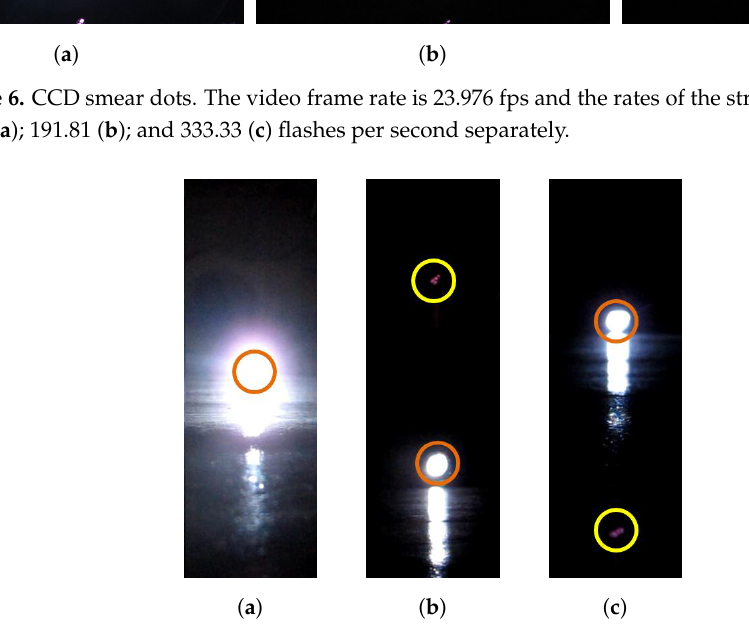
Figure 7. Smear effects when the video frame rate equals the flash rate of the strobe light. The orange circle indicates the light source position and the yellow circle indicates the smear dot position. ( a ) shows that the strobe turns on in the acquisition phase; and ( b , c ) show the situations in which smear dots appear above and below the strobe position